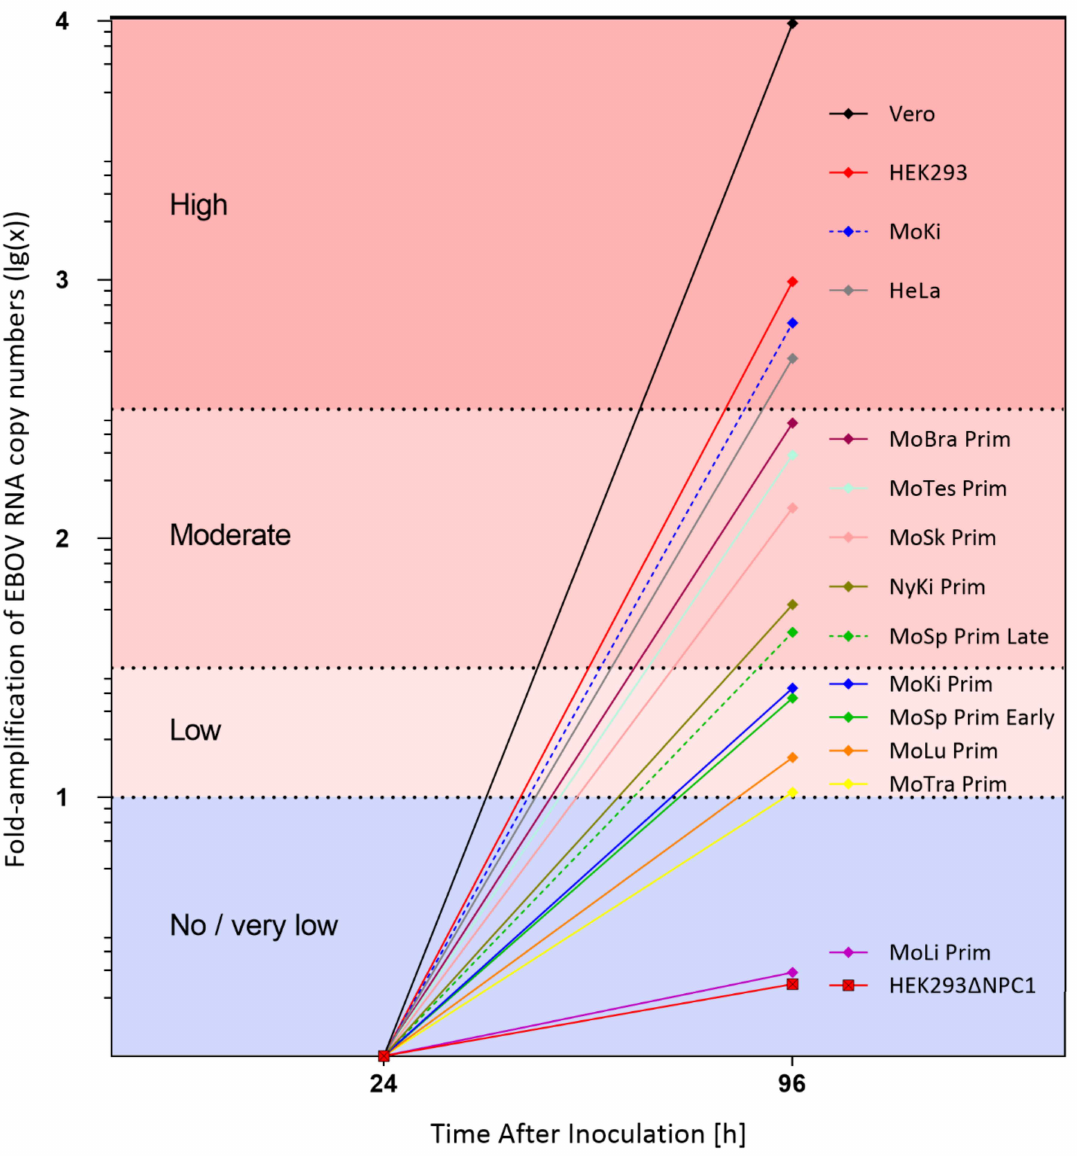
Figure 1. Fold-amplification of EBOV RNA copy numbers (lg(x)) between 24 and 96 hpi. Viral RNA copy numbers/mL in supernatants of infected cell isolates were determined by qRT-PCR and calculated from three replicates per